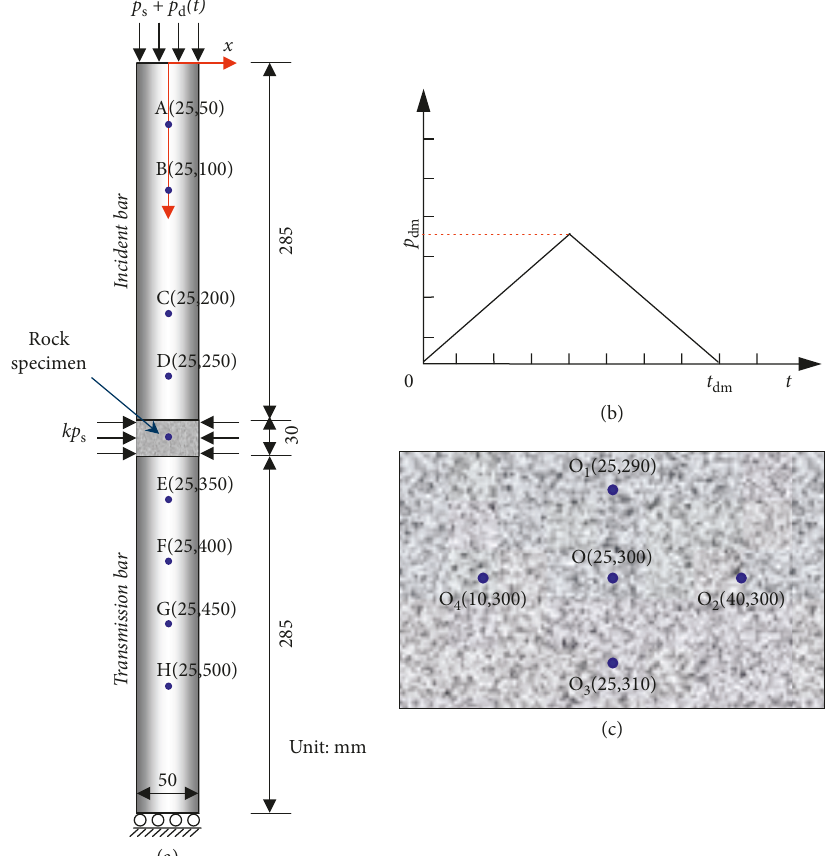
Figure 3: Model setup for SHPB test of rock under combined static and dynamic loading (unit: mm) [112]: (a) model; (b) the waveform of dynamic stress p d ( t ) with an amplitude of p dm and duration of t dm ; (c) amplified rock specimen, in which 5 typical points where the stress or strain will be retrieved and averaged.